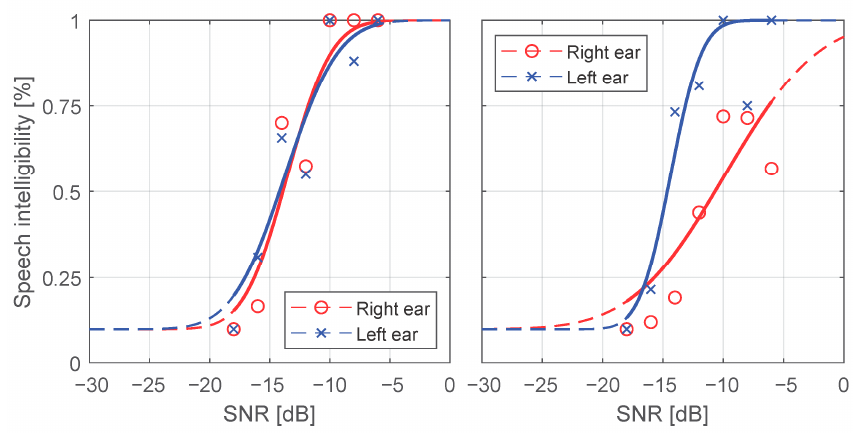
Figure 3. Examples of the speech intelligibility ratio in relation to the signal-to-noise ratio (SNR) fitted with the psychometric function for continuous noise (right panel—a subject of the control group, left panel—a subject of the investigated group with right-sided hearing impairment).